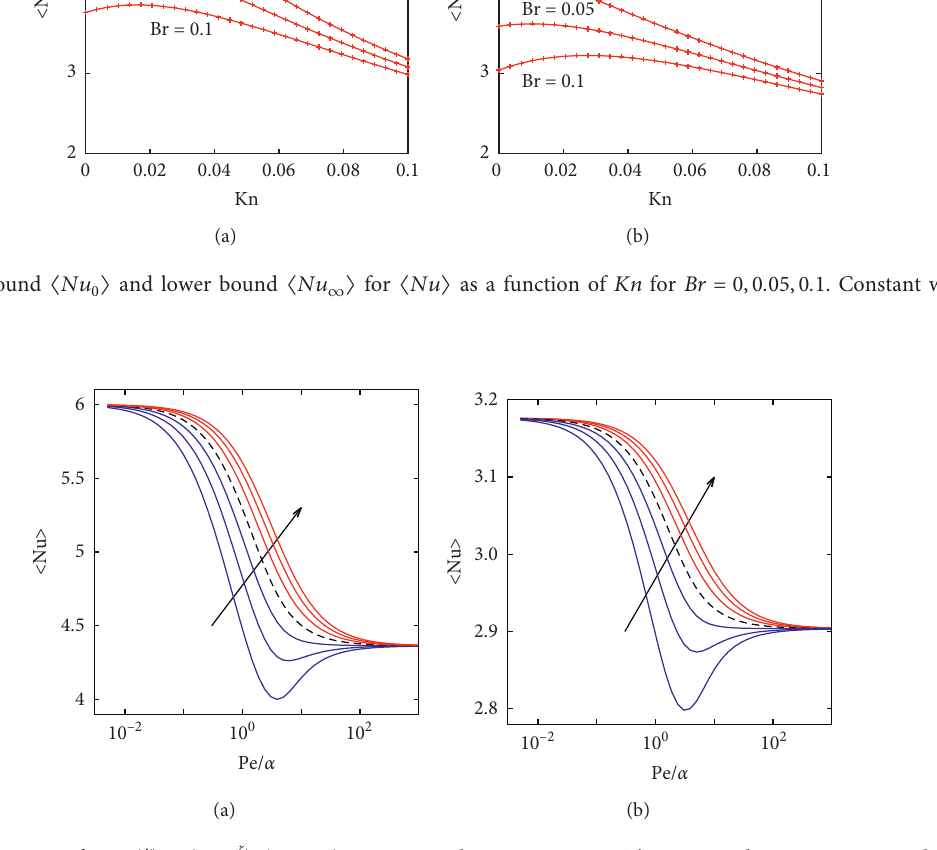
〉 and lower bound 〈 Nu 0